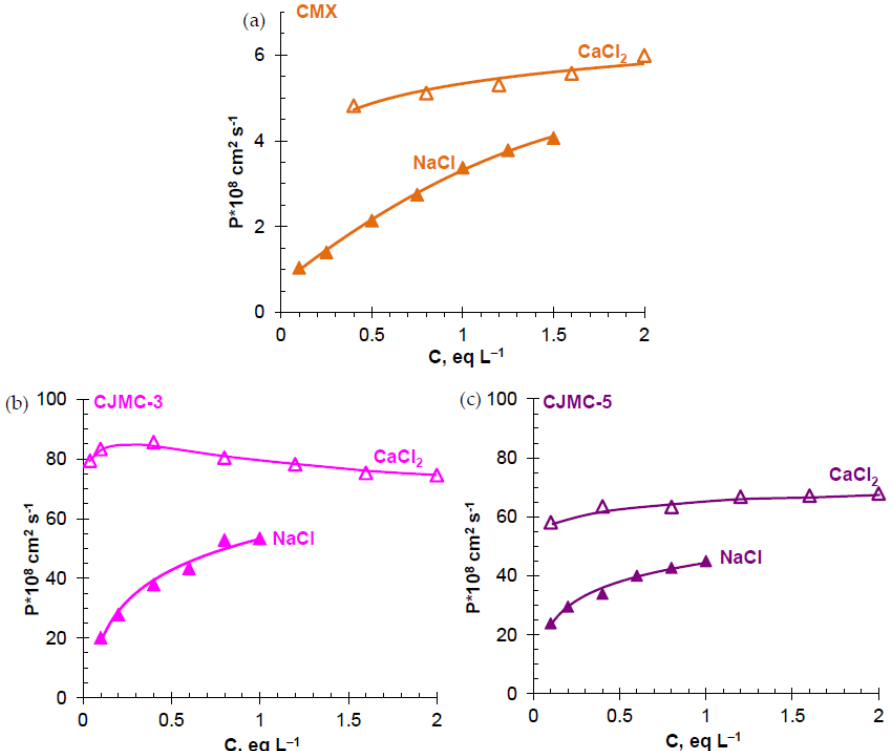
Figure 5. Concentration dependences of the integral diffusion permeability coefficient of CMX ( a ), CJMC-3 ( b ), and CJMC-5 ( c ) membranes vs. concentration of NaCl and CaCl 2 solutions. The lines are for the guide of eyes.